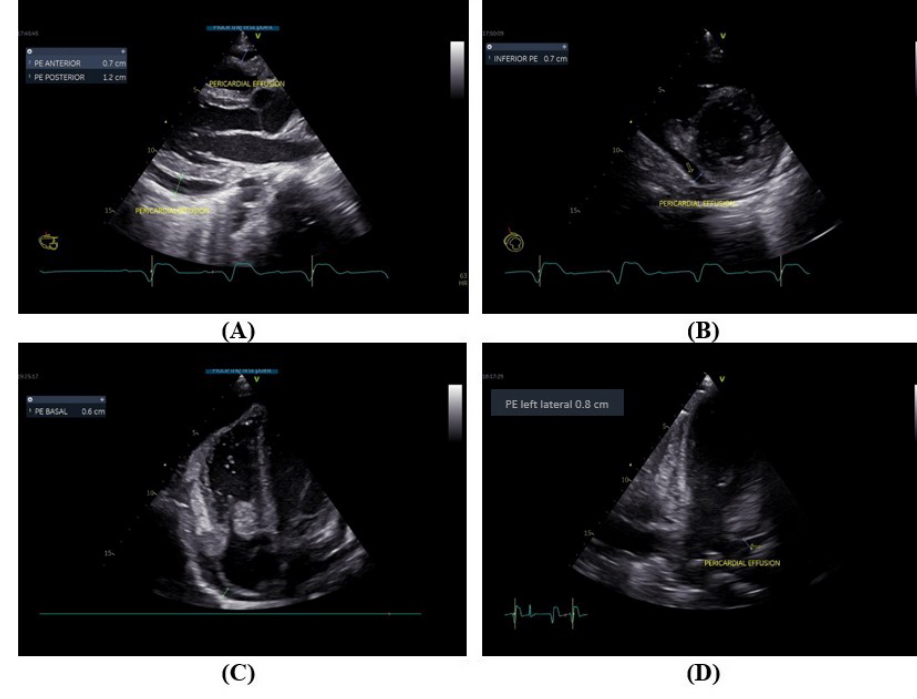
Figure 3. Pericardial effusion was found in ( A ) anterior, posterior, ( B ) inferior, ( C ) base, and ( D ) left-lateral of the